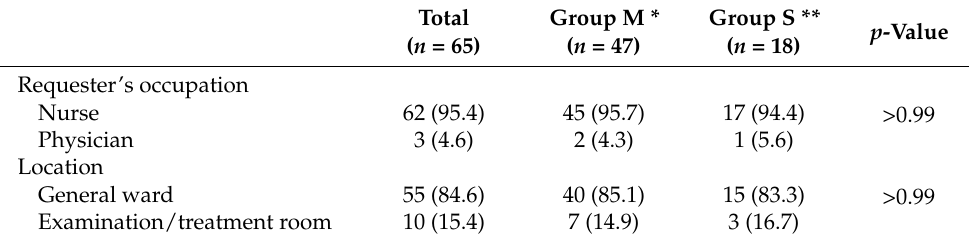
Table 3. Background of rapid response team (RRT) request.